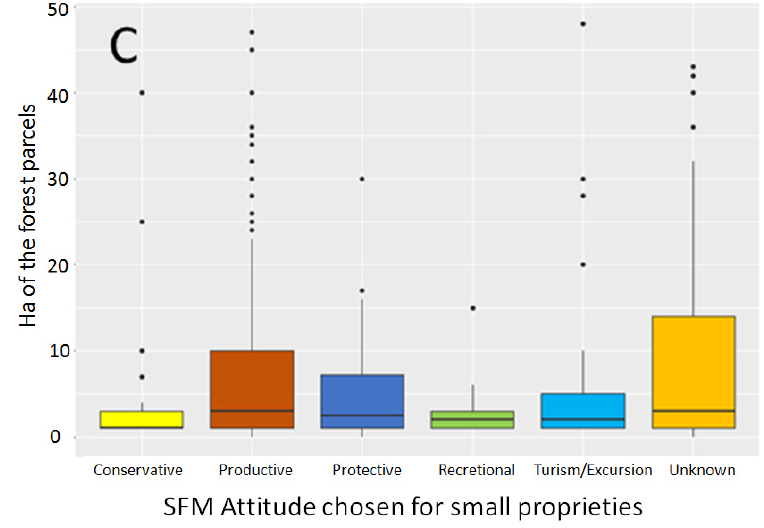
Figure 4. Boxplot representing the distribution of the area of forest properties per first SFM attitude Panel ( A ). For larger forest proprieties (total forest area ≥ 100 ha). Panel ( B ). for medium forest properties (50 ≤ total forest area < 100 ha) Panel ( C ). For small forest properties (total forest area < 50 ha).